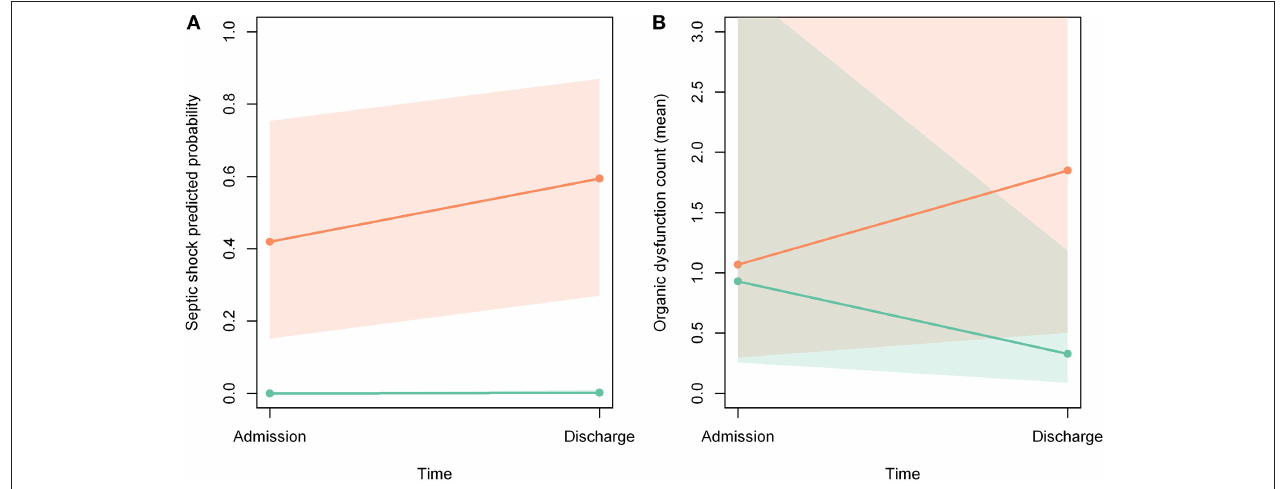
FIGURE 2 | (A,B) Probability of developing septic shock and organ dysfunction during hospitalization. Orange line: patients not included in the protocol; green line: patients included in the protocol; orange area: confidence interval of patients not included; green area: confidence interval of patients included; gray zone: intersection of confidence intervals.